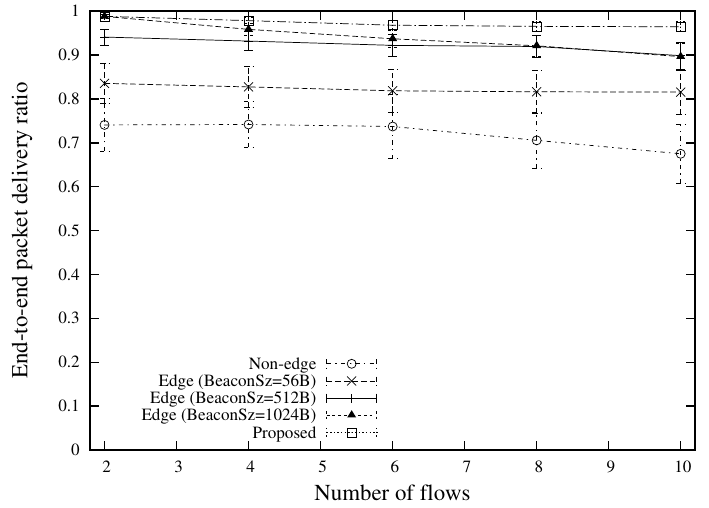
Figure 10. End-to-end packet delivery ratio for various numbers of flows (the case of 400 m source-destination